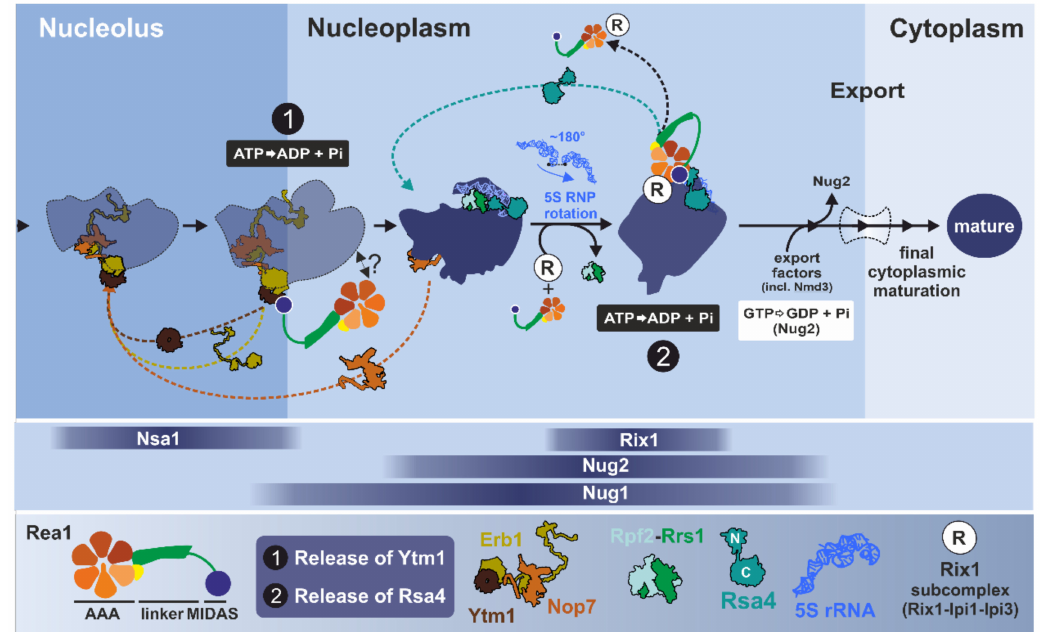
Figure 8. Two-step remodeling of pre-60S particles by Rea1. Yeast Rea1 is proposed to associate with the pre-60S particle at two distinct stages, these being first at the transition from the nucleolus to the nucleoplasm and secondly at a later stage of nucleoplasmic maturation. Both maturation stages are associated with the ATP-dependent release of maturation factors (Ytm1-Erb1 and Nop7 as well as Rsa4) and structural rearrangements of the pre-ribosome (e.g., rotation of the 5S RNP). In the nucleoplasm, the Rix1 sub-complex binds to the particle and recruits Rea1 via direct interaction between Rix1 and Rea1. Downstream, the release of Rsa4 is followed by GTP-dependent dissociation of Nug2 and loading of Nmd3, which is a prerequisite to render the particle export